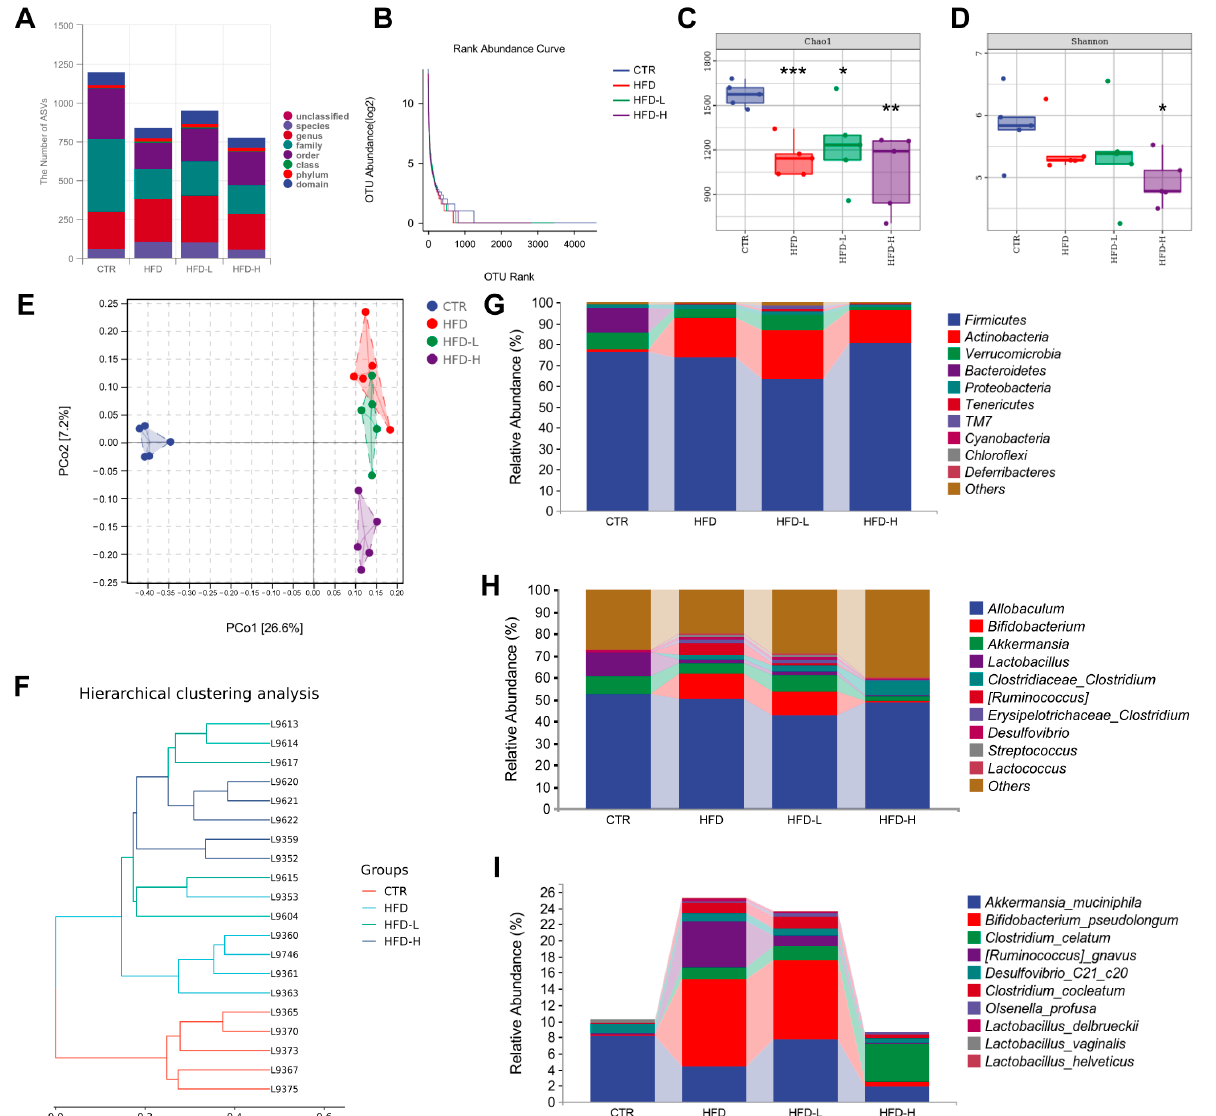
Figure 6. SMRR polysaccharide modulates the composition and structure of gut microbiota. ( A ) Quantification shows decreased numbers of ASVs of gut microbiota in HFD, HFD+L and HFD+H, compared with CTR. ( B ) OTU Rank–Abundance Curves of gut microbiota for different groups. ( C ) Bacterial community richness measured by Chao1 index in different groups; “*” stands for the comparation with CTR; * p < 0.05, ** p < 0.01, *** p < 0.001 by one-way ANOVA. ( D ) Bacterial community diversity measured by Shannon index in different group. * p < 0.05 by one-way ANOVA; ( E ) Unweighted UniFrac Principal Coordinate Analysis by bacterial microbiota. CTR shows clear separation with the other groups. ( F ) Bray Curtis cluster tree shows samples from CTR, HFD, and HFD+L trend to cluster together. ( G – I ) Microbial composition at the phylum, genus and species level. Groups are represented along the horizontal axis and relative abundance is denoted by the vertical axis.